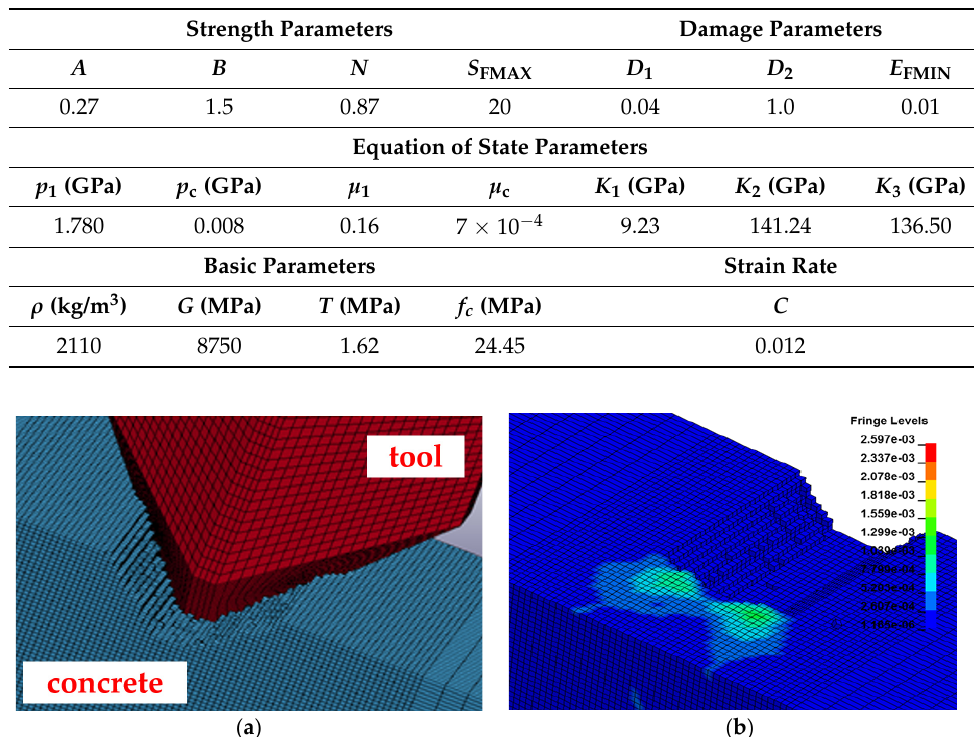
Table 2. Parameters for the HJC model.